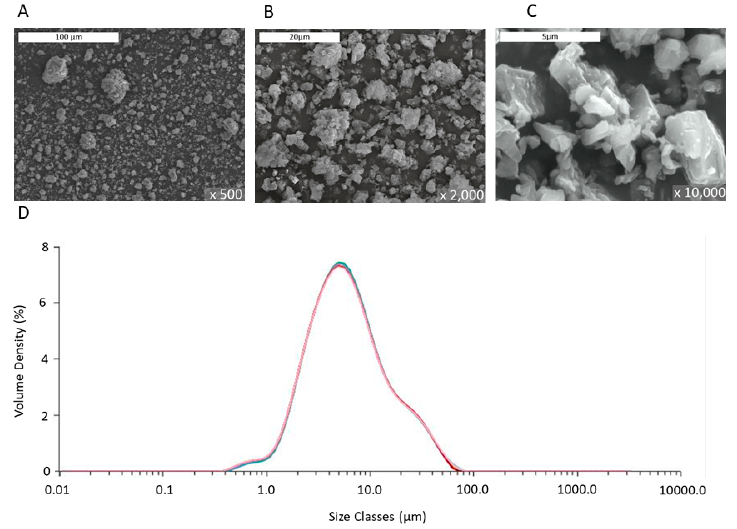
Figure 2. Images of MgO powder studied by SEM at different magnifications: ×500 times ( A ), ×2000 ( B ), and ×10,000 ( C ). ( D ) Particle size distribution of MgO powder by laser diffraction analysis of a dispersion in pure ethanol repeated 10 times (multiple curves shown) to ensure measurement accuracy.